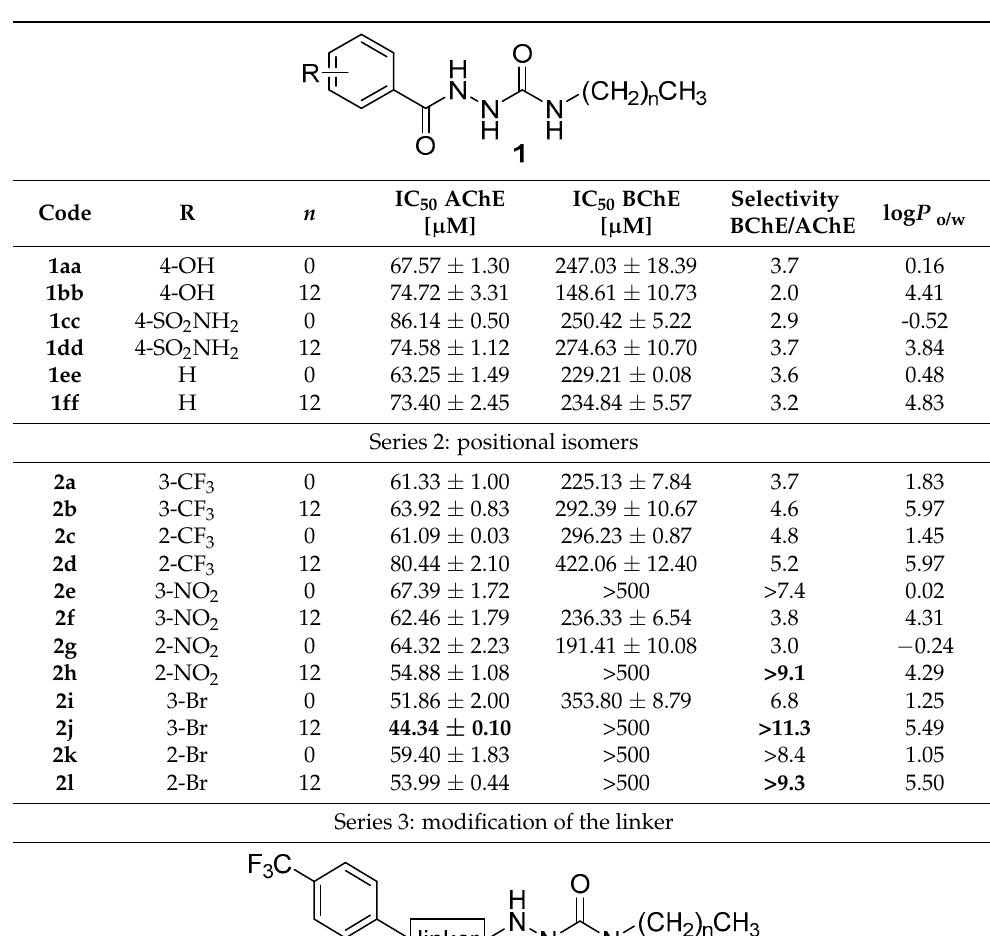
Table 2. Inhibition of AChE and BChE, selectivity indexes and lipophilicity of hydrazinecarbox- Table 2. Cont. amides 1–3